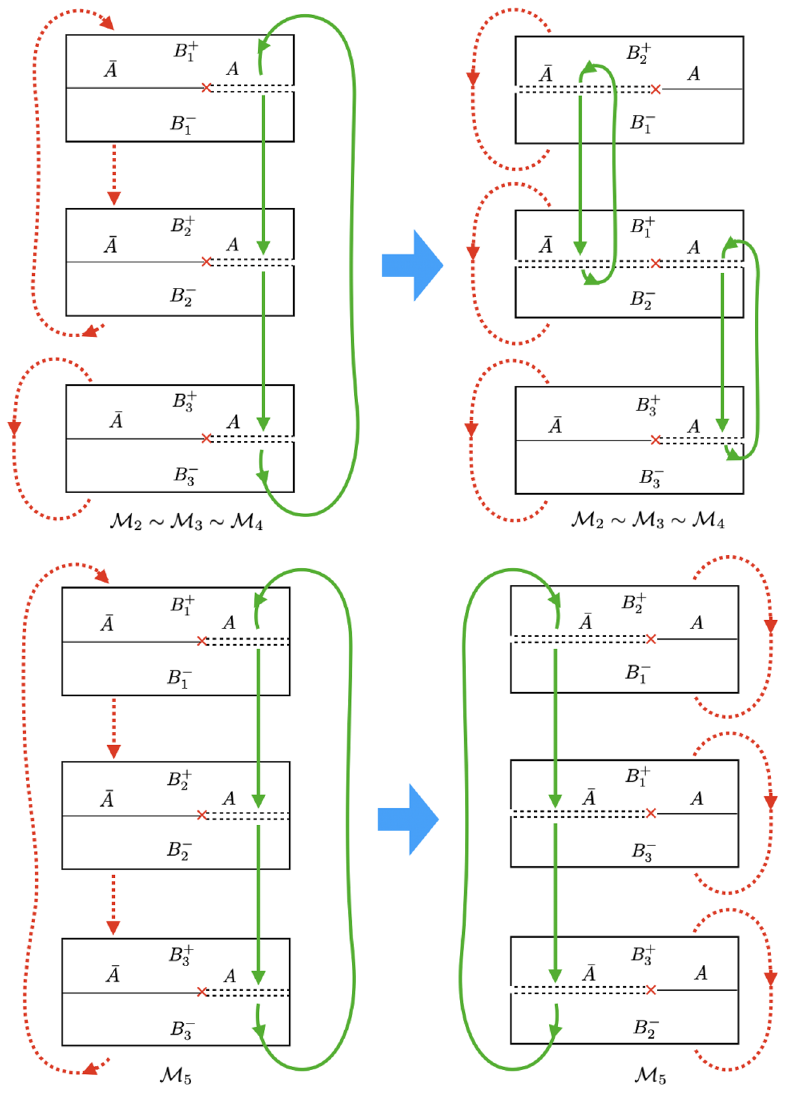
Figure 5 . \Canonical" representations of M 2 (cid:24) M 3 (cid:24) M 4 and M 5 for n = 3. and (cid:22) A respectively, this is similar to the approach taken in [8]. The matching details at the junctions are not important for our